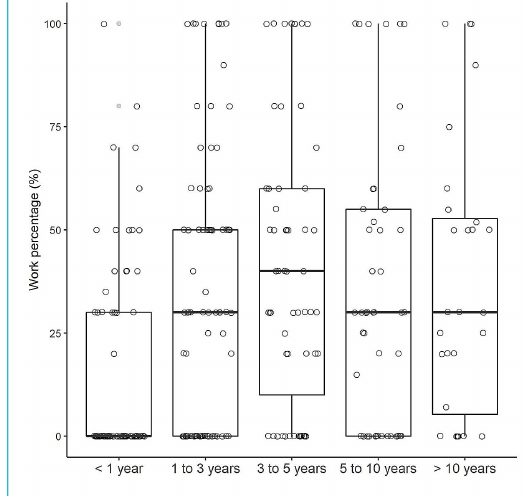
Figure 1: Boxplot for work percentage for all pre-specified time pe- riods after lung transplantation. The box shows the median and in- terquartile ranges (i.e., 25th and 75th percentiles) with the mini- mum and maximum values. Outliers are defined as values greater than 1.5 × interquartile range (grey filled circles).